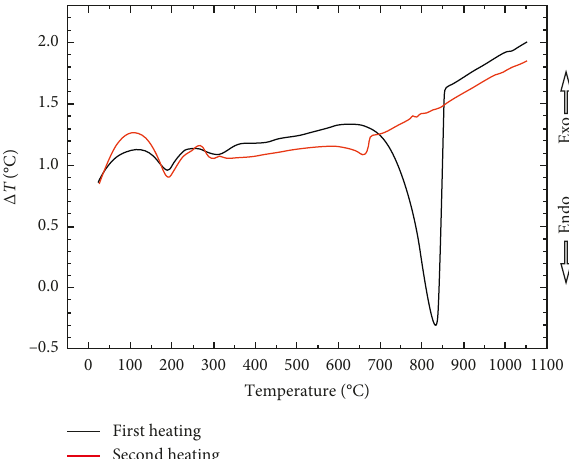
Figure 3: Comparison of DTA heating curves of sample L600.